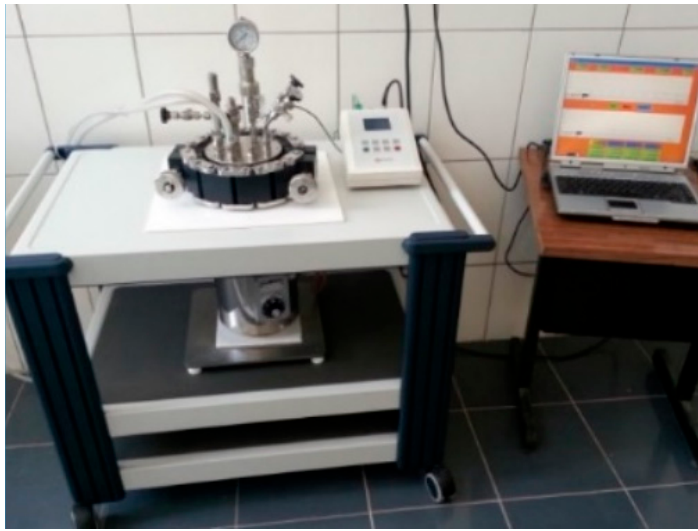
Figure 1. The Berghof autoclave experimental device.